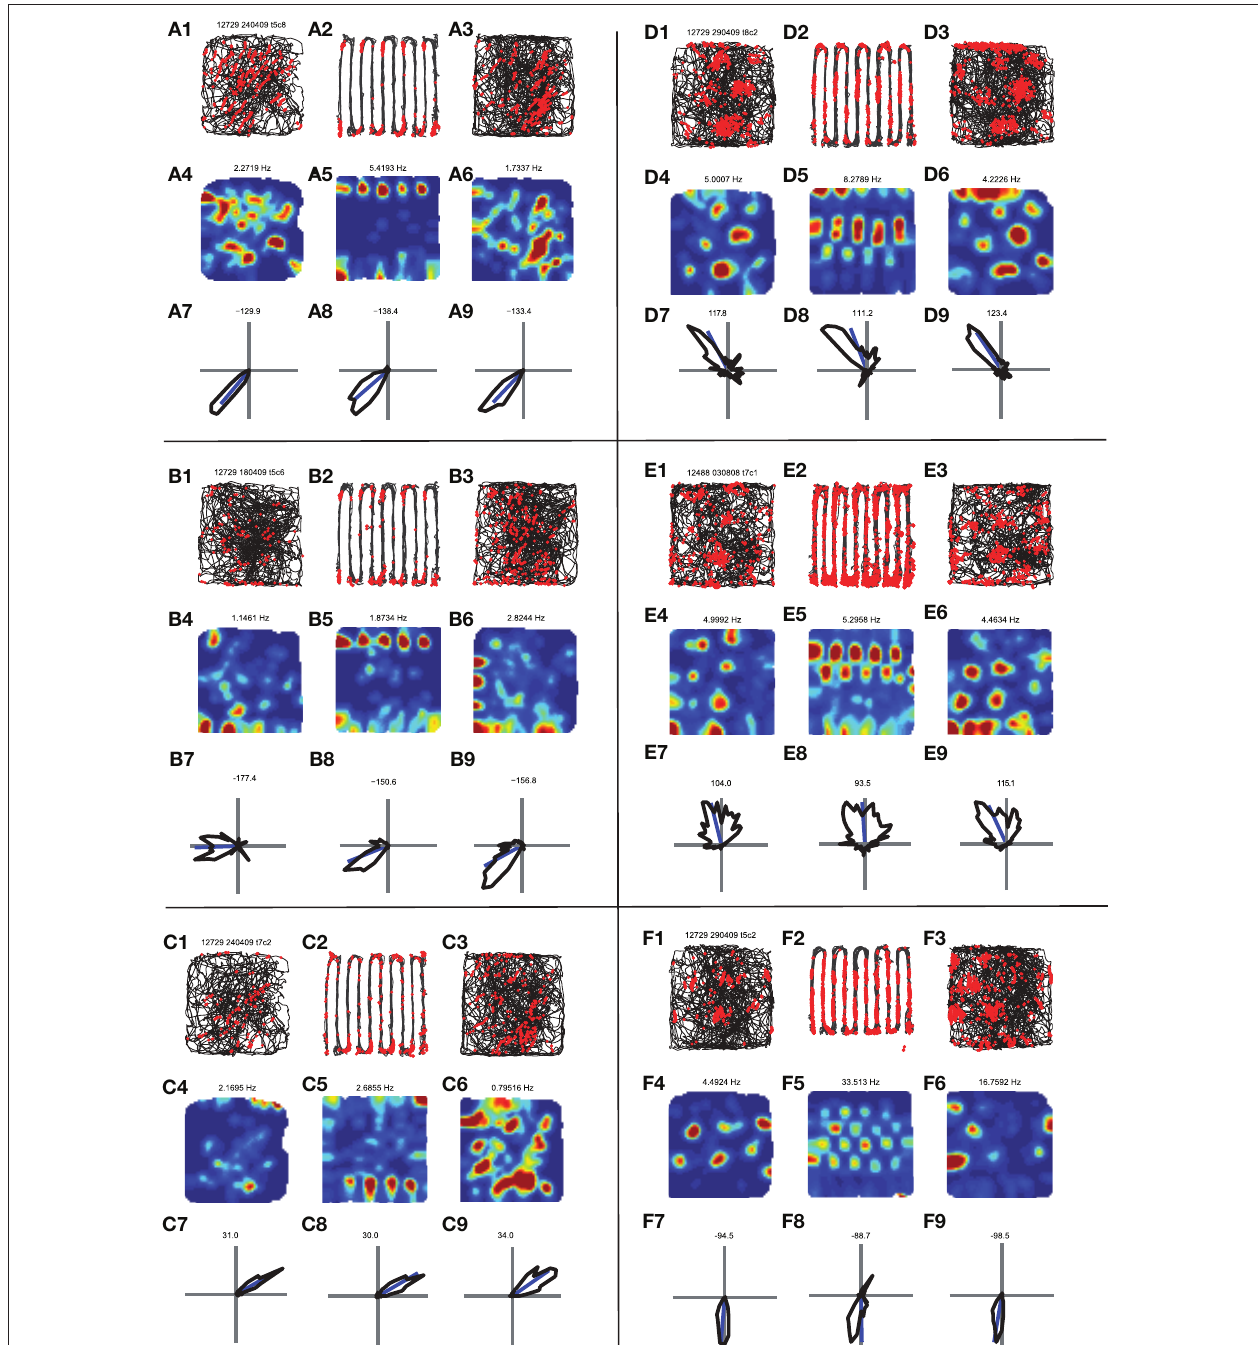
FIGURE 3 | Comparison of the behavior of head direction cells in the open-field vs. the hairpin maze. (A) A head direction cell. (A1) Path and spikes in first open-field trial. (A2) Path and spikes in hairpin trial (A3) path and spikes in second open-field trial. (A4) Rate map in first open-field trial (generated from A1 ). (A5) rate map in hairpin trial (generated from A2 ). (A6) Rate map in second open-field trial (generated from A3 ). (A7) Head direction polar histogram in first open-field. Blue line is the preferred direction of the cell. (A8) Head direction polar histrogram in hairpin trial. (A9) head direction polar histogram in second open-field. Note the similar